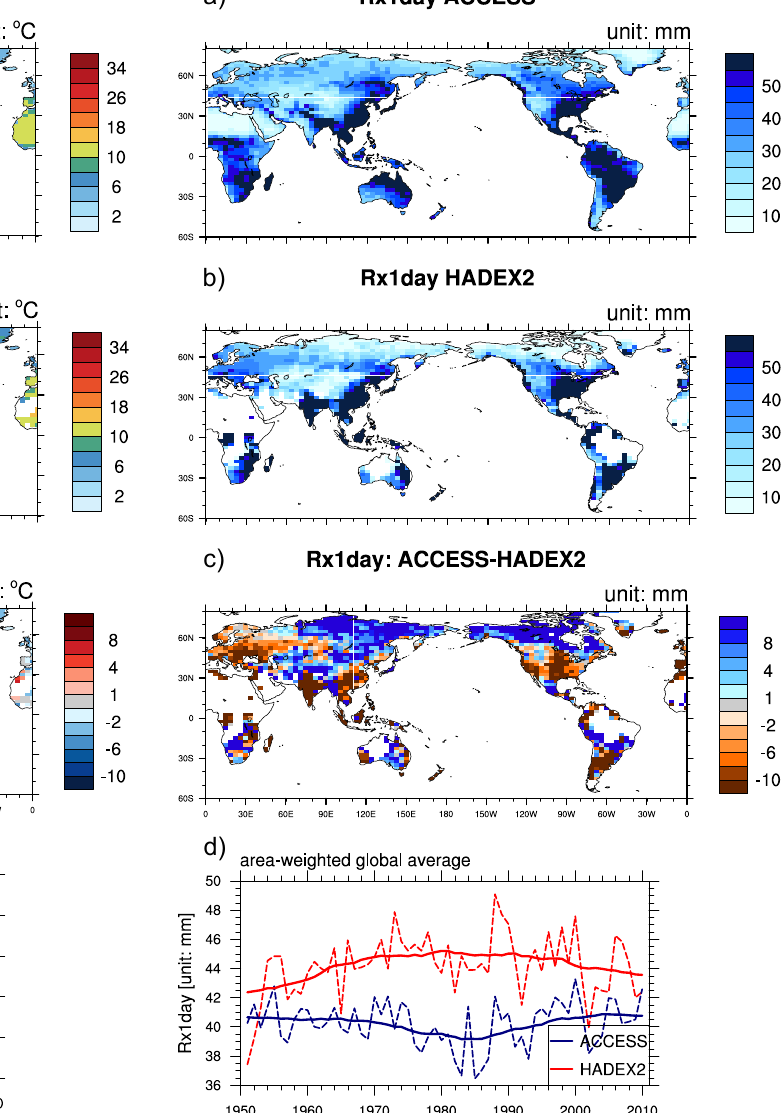
Fig. 7. Annual maximum consecutive 1-day precipitation (Rx1day) for ACCESS1.3b (a) , HadEX2 (b) , bias (c) and the global aver- age time series showing trends (d) . Unshaded areas reflect missing observation data. We applied a static masked only including grid points where more than 50 years of data (out of 60) were available to calculate the global average. The solid lines in (g) show the time series smoothed by a 21-year Gaussian filer, while the dashed lines show the yearly